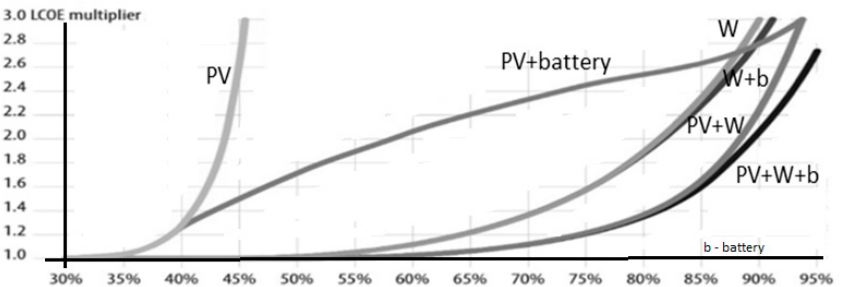
Figure 14. Levelized cost of electricity and electrolyzer utilization for different power supply options: PV; PV + battery; wind; wind + battery; PV + wind; PV + wind + battery.